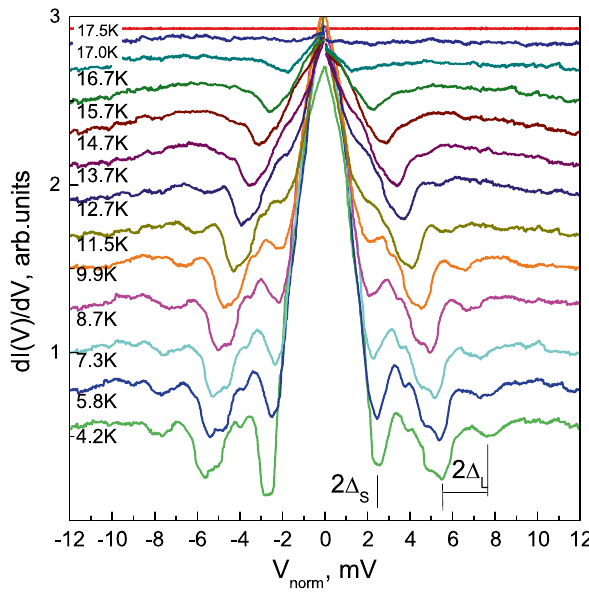
Fig. 2 Temperature evolution of the dI(V)/dV spectrum of SnS–Andreev array (the same as the curve ♯ 1 in Fig. 1, m = 4 ). T local 17.5 K. The monotonic normal-state background is sup- c ≈ pressed. The normal conductance G ( V > 10 mV ) → G N is constant with temperature; the dI(V)/dV curves are manually shifted along the vertical axis for clarity. For the lowest curve (4.2 K), the verti- cal dashes point to the positions of the fundamental Andreev dips of the Δ L superconducting gap (doublet) and the small gap Δ S . ≡ V ∕ V norm